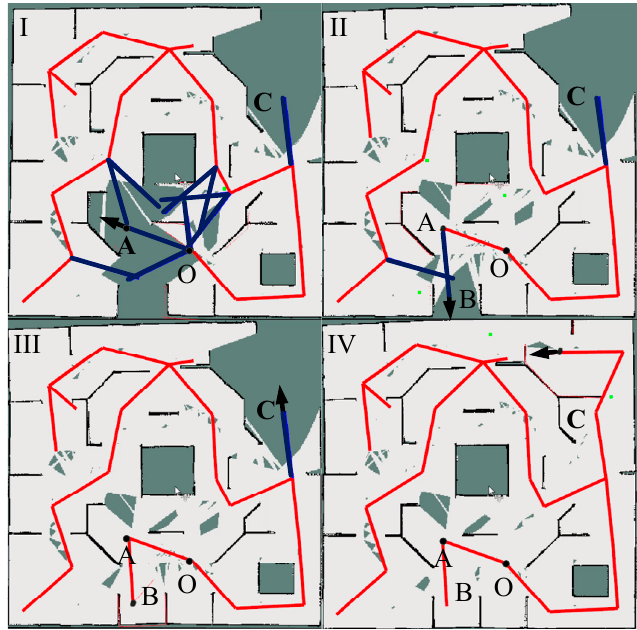
Figure 10. Exploration process: ( I ) Map established after rounds of exploration; ( II ) Map after the robot reached point A; ( III ) Map after the robot reached point B; ( IV ) Final map after the exploration; Point A is a target point in ( I ) and a visited topology node in ( II – IV ); Point B is a target point in ( II ) and a visited topology node in ( III and IV ); Point C is a candidate topology node in ( I – III ) and a visited topology node in ( IV ); Point O is a visited topology node in ( I – IV ).